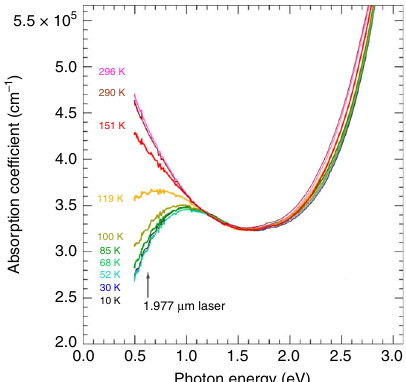
Fig. 1 Optical absorption spectra at different temperatures without external magnetic fi elds. The arrow indicates the energy of the laser used for the magneto-transmission